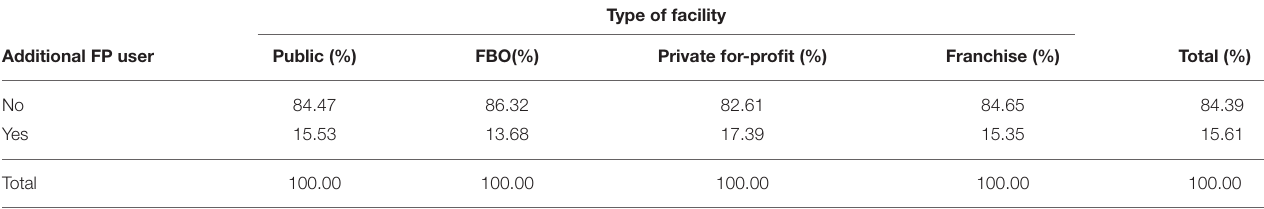
TABLE 7 | Proportion of Additional Users of FP, by Sector.